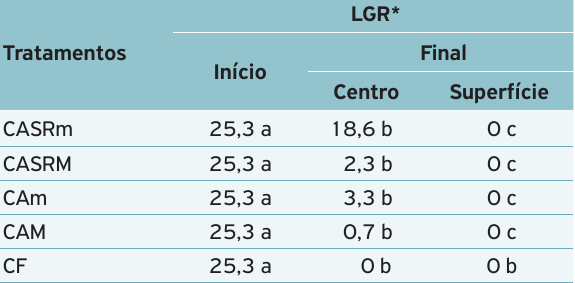
central e superficial das composteiras, respectivas aos